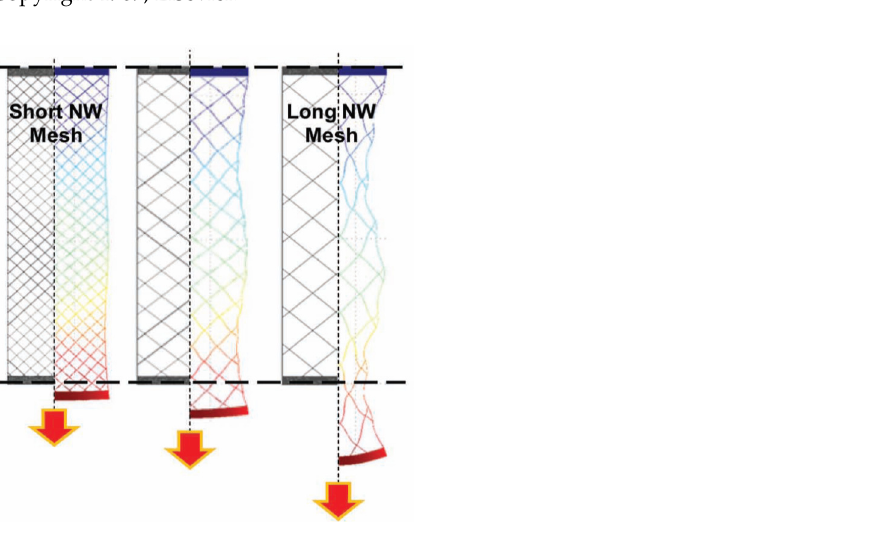
Figure 3. ( a ) Ion beam images of silver thin film with a thickness of 1.5 µm taken by a focused ion beam (FIB), ( b ) an enlarged image at a black dot square in ( a ), and cross-sectional SEM image of a silver thin film damaged by repeated deformation. Reproduced with permission from ref. [32]. Copyright 1969, Elsevier.